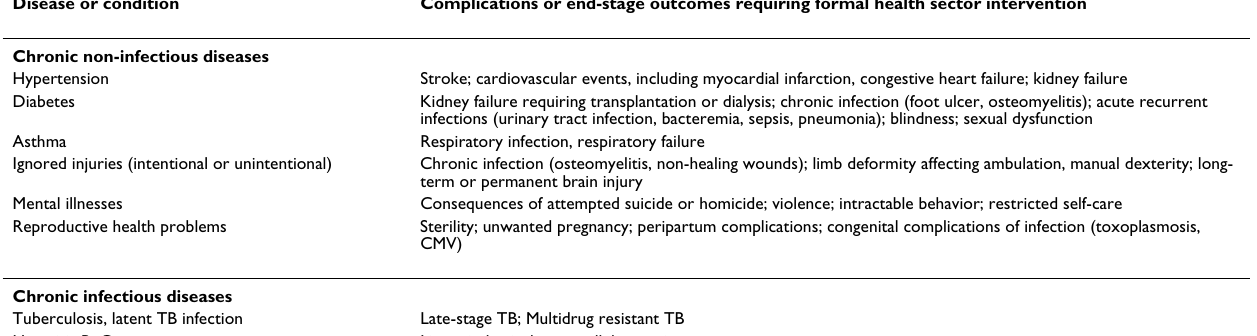
Table 1: Diseases that are chronic or associated with chronic conditions whose complications or end-stage outcomes require long- term medical intervention by the formal health sector services. Disease or